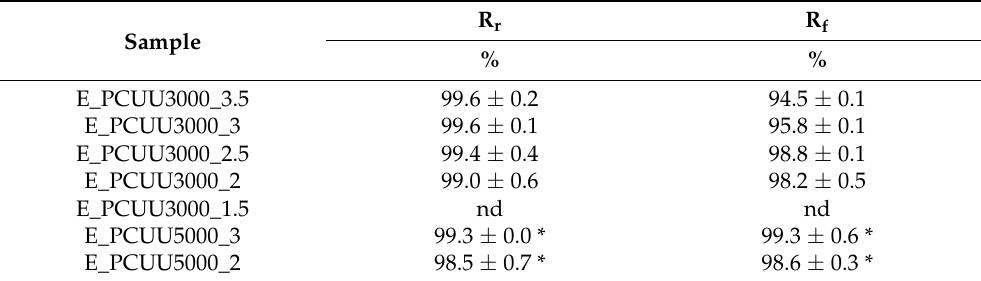
Table 6. Shape-memory properties of PCUU samples.